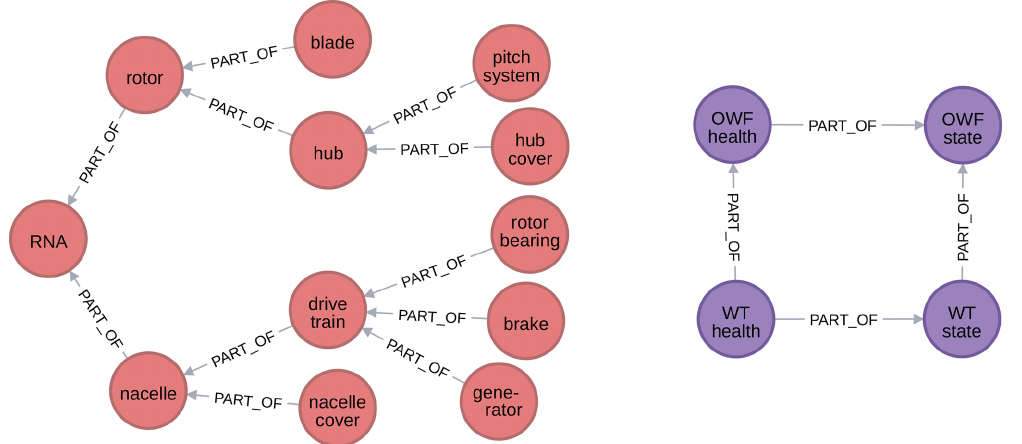
Figure 5. Excerpts from WESgraph of the subgraphs defined by the PART OF relationship.